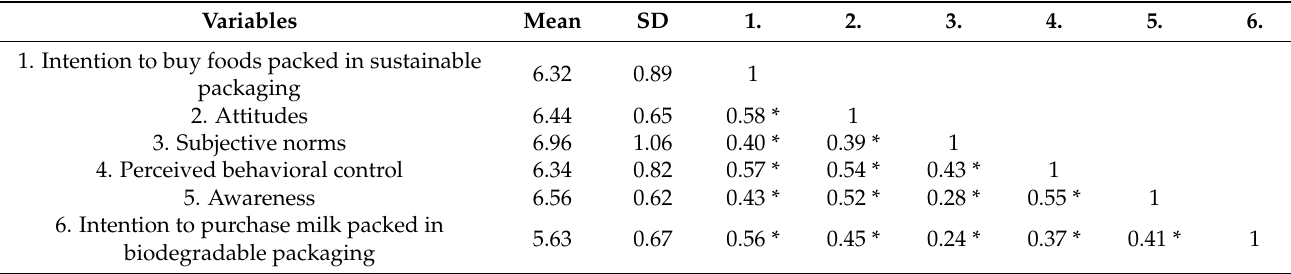
Table A3. Descriptive statistics and correlations ( n = 260).